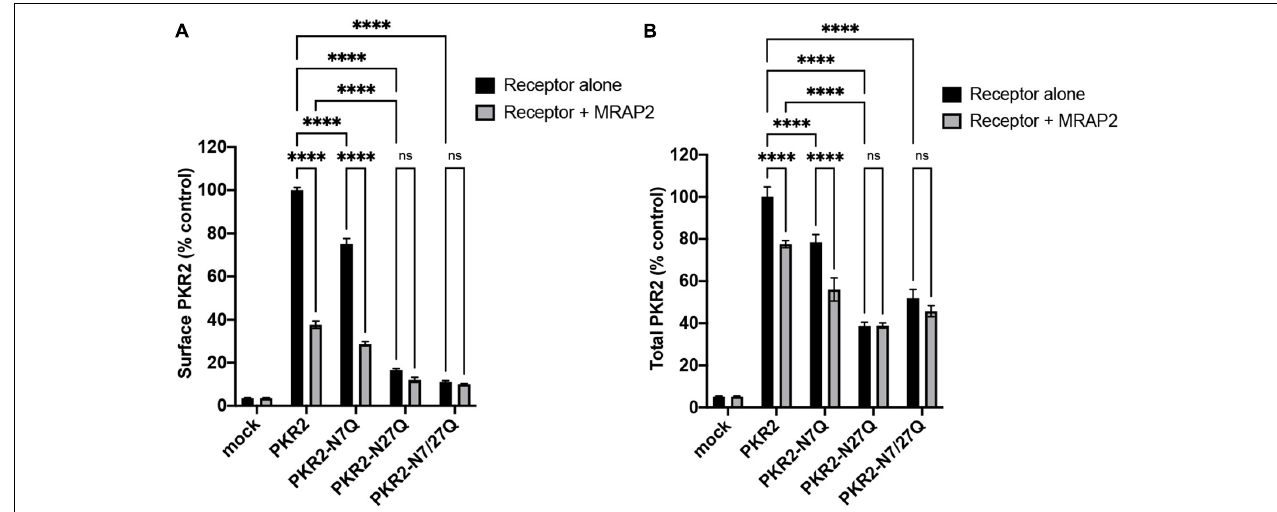
FIGURE 3 | Surface and total quantitation of PKR2 and PKR2 mutants with and without MRAP2. (A) Cell ELISA detection of 2HA-PKR2 and 2HA-PKR2 mutants expressed alone or with MRAP2 in non-permeabilized cells. (B) Cell ELISA detection of 2HA-PKR2 and 2HA-PKR2 mutants expressed alone or with MRAP2 in permeabilized cells. Errors are mean ± SEM. ∗∗∗∗ p <